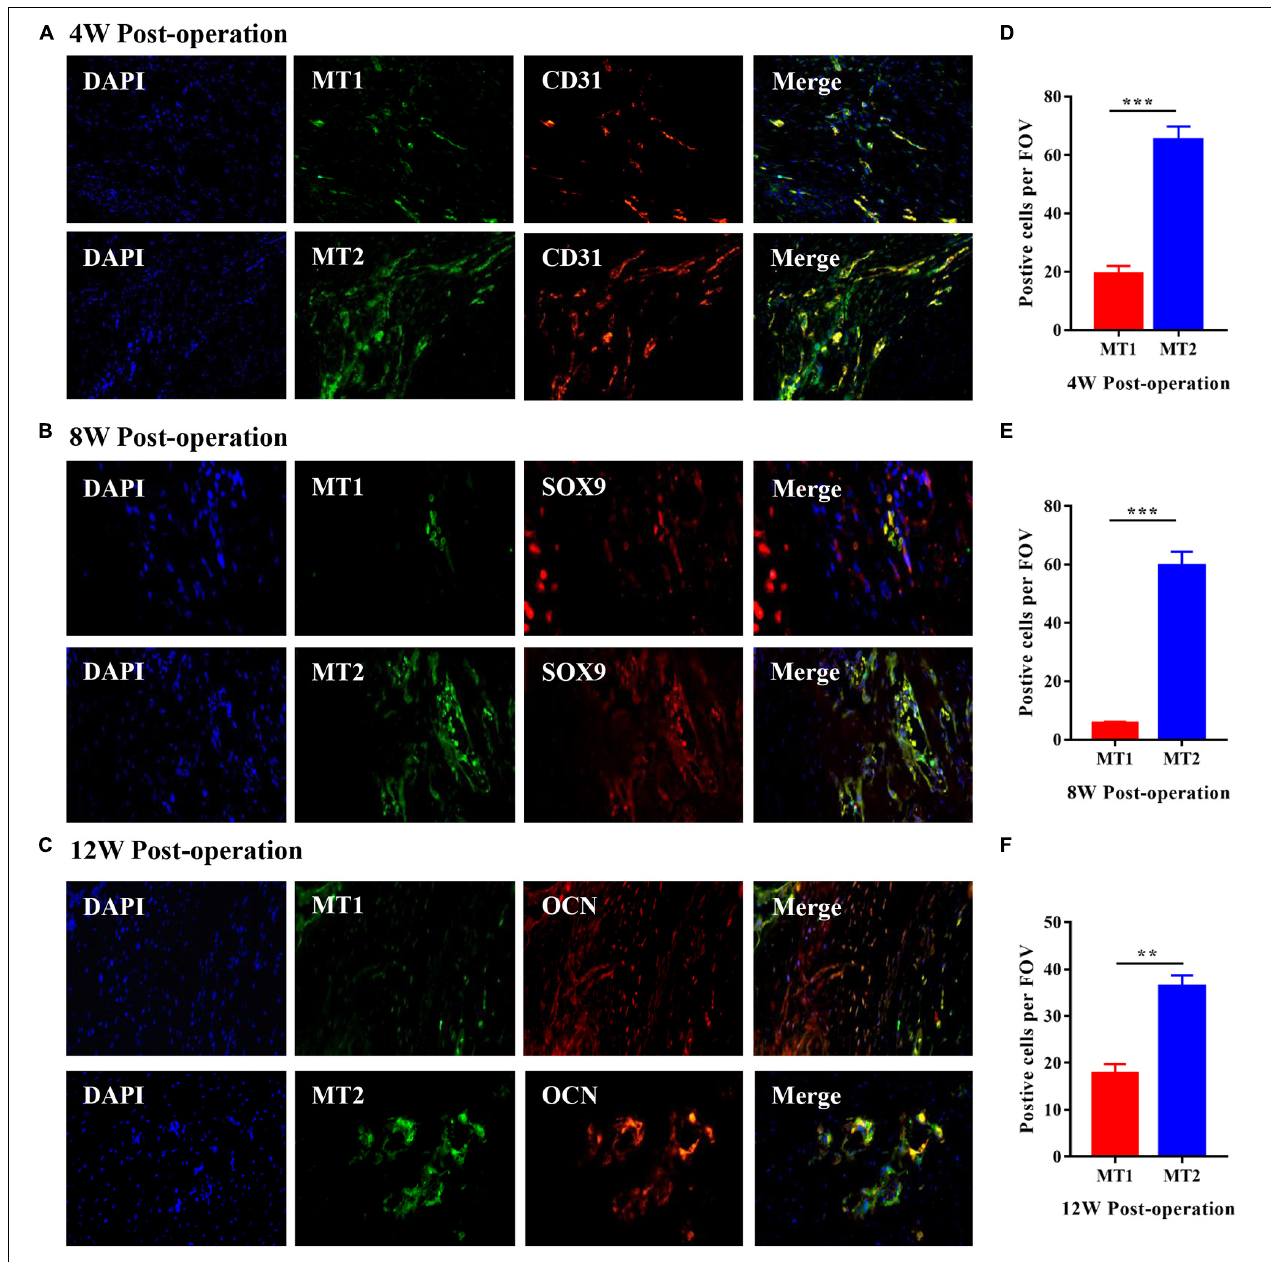
FIGURE 2 | Roles of the MT1 and MT2 melatonin receptors throughout HO formation in injured Achilles tendons. (A) IFC analysis of HO specimens of injured Achilles tendons at 4 weeks after the operation with antibodies specific for the vascular endothelial marker CD31 (red), the MT1 melatonin receptor (green) and the MT2 melatonin receptor (green). Images show the coexpression of CD31 and MT1 (upper) and the coexpression of CD31 and MT2 (bottom). (B) IFC analysis of HO specimens from injured Achilles tendons at 8 weeks after the operation with antibodies specific for the chondrogenic marker SOX9 (red), the MT1 melatonin receptor (green) and the MT2 melatonin receptor (green). Images show the coexpression of SOX9 and MT1 (upper) and the coexpression of SOX9 and MT2 (bottom). (C) IFC analysis of HO specimens from injured Achilles tendons at 12 weeks after the operation with antibodies specific for the osteogenic marker OCN (red), the MT1 melatonin receptor (green) and the MT2 melatonin receptor (green). Images show the coexpression of OCN and MT1 (upper) and the coexpression of OCN and MT2 (bottom). Blue represents nuclear DAPI staining. Scale bar, 20 µ m. (D–F) The number of MT2-positive cells was higher than that of MT1-positive cells at the indicated time points. The data represent the mean ± SD. ** P < 0.01, *** P < 0.001 versus the MT1